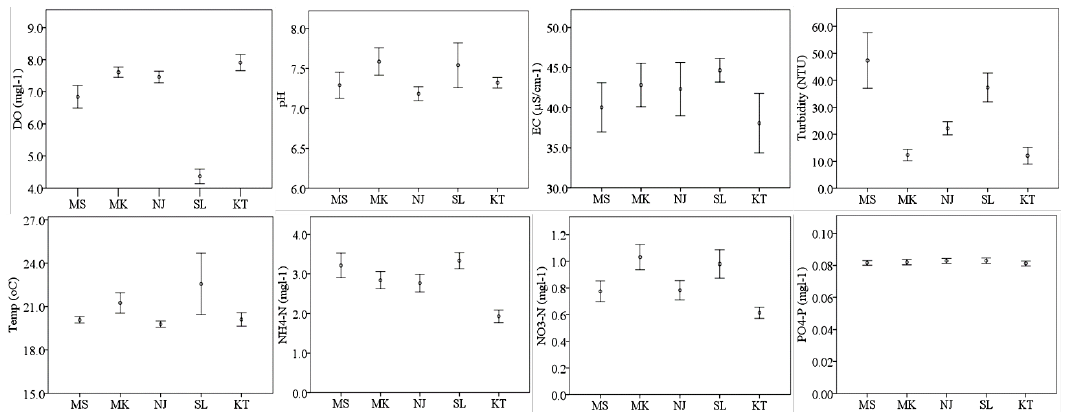
Figure 2. Physical-chemical parameters (mean ±SE), dissolved oxygen (DO), pH, electrical conductivity (EC), turbidity, temperature, ammonium-N, nitrate-N, and phosphate-P) of water quality measured in the five selected streams in Kilombero Valley: MS — Msolwa stream, MK — Mkula stream NJ — Njage stream, SL — Sululu stream and KT — Kidete stream (least impacted).